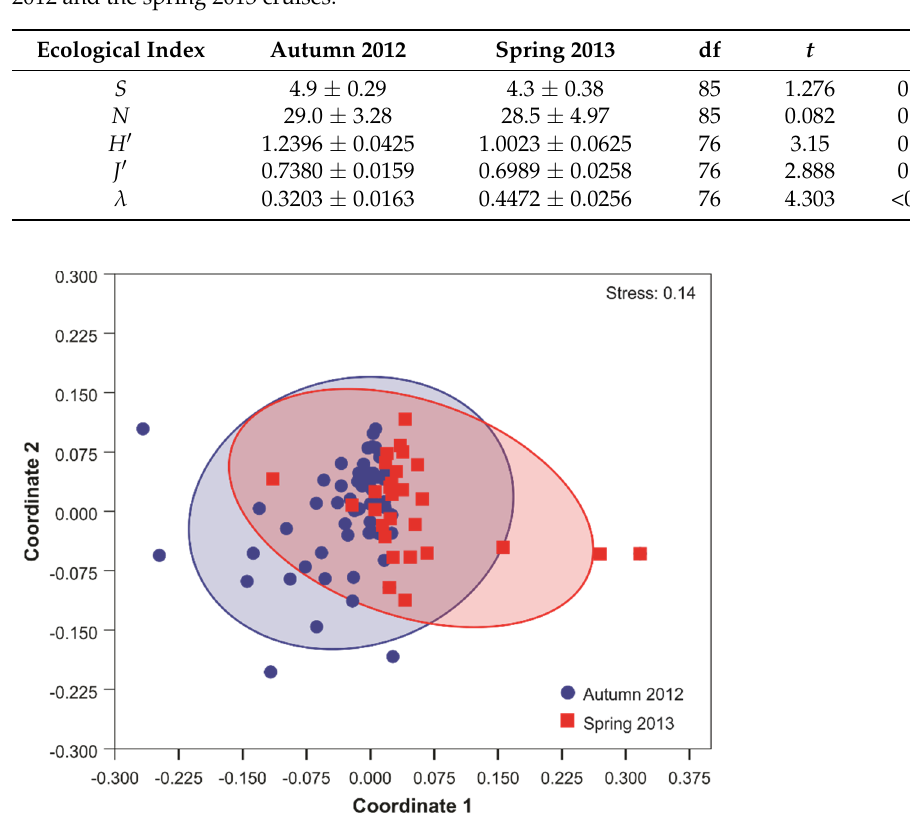
Table 5. Ecological indices for phyllosomata by cruise. Mean ± standard deviation of species richness ( S ), number of individuals ( N ), Shannon–Wiener’s diversity ( H (cid:48) ), Pielou’s evenness ( J (cid:48) ), and Simpson’s dominance ( λ ), and results of Student’s t -tests comparing each index between the autumn 2012 and the spring 2013 cruises.